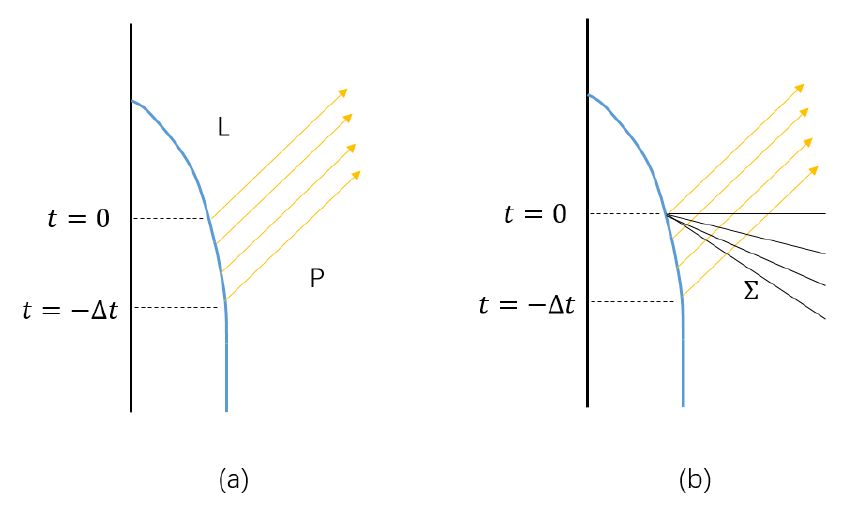
Figure 6 . (a) An illustration of the set up. In the (cid:12)gure, only the left part of the spacetime is drawn. We denote the regions before and after the shock waves as P and L. (b) We vary the slice (cid:6) with left end (cid:12)xed at t = 0, to (cid:12)nd the one that maximizes the quantum